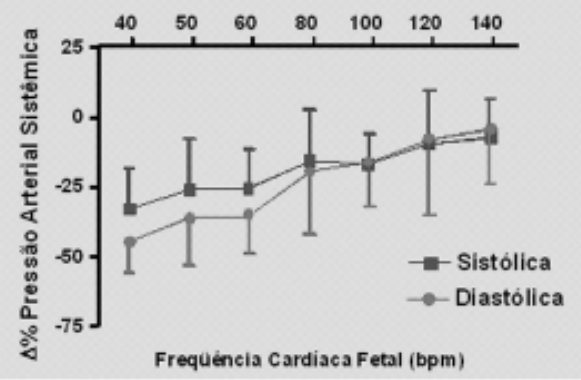
Fig. 4B - Relação da variação porcentual da pressão sistêmica fetal com a freqüência cardíaca fetal. n = 4, Valores = média ± desvio